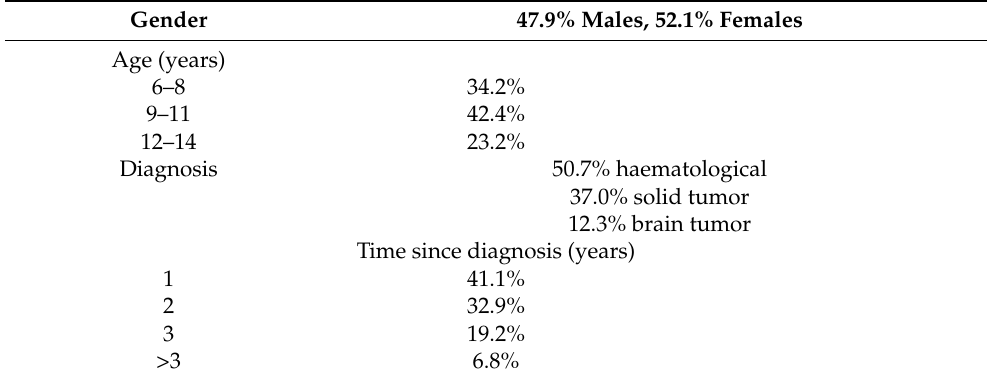
Table 1. Patients’ characteristics (n =